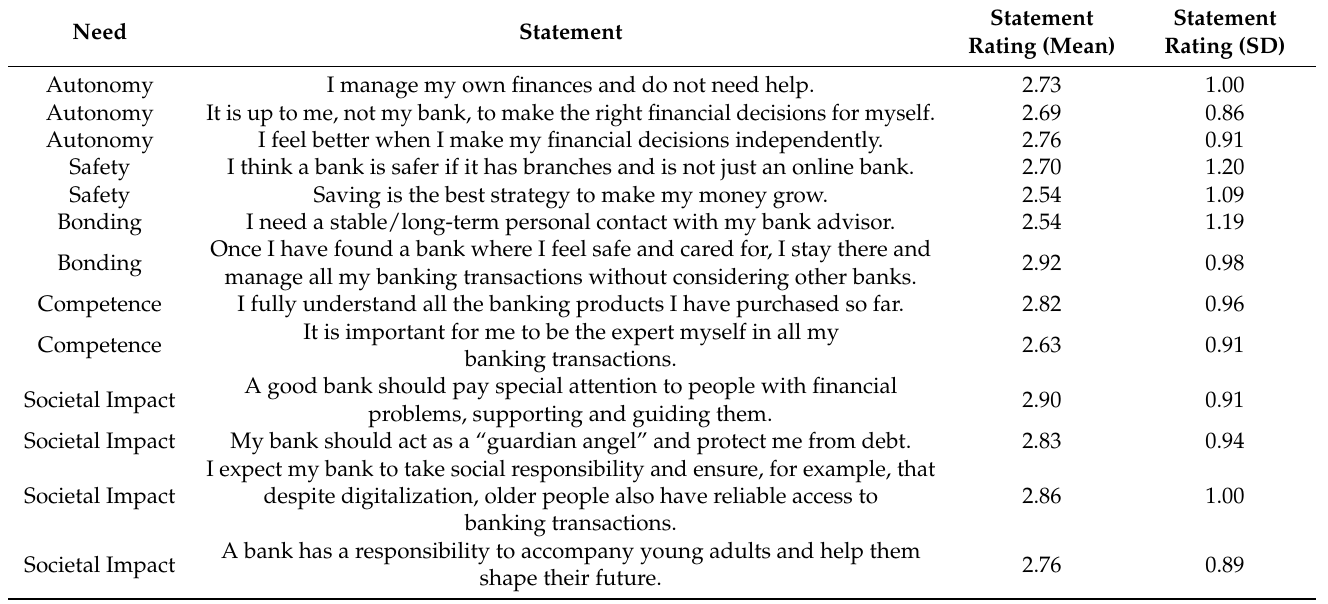
Table 5. Need Statements for the Target Group